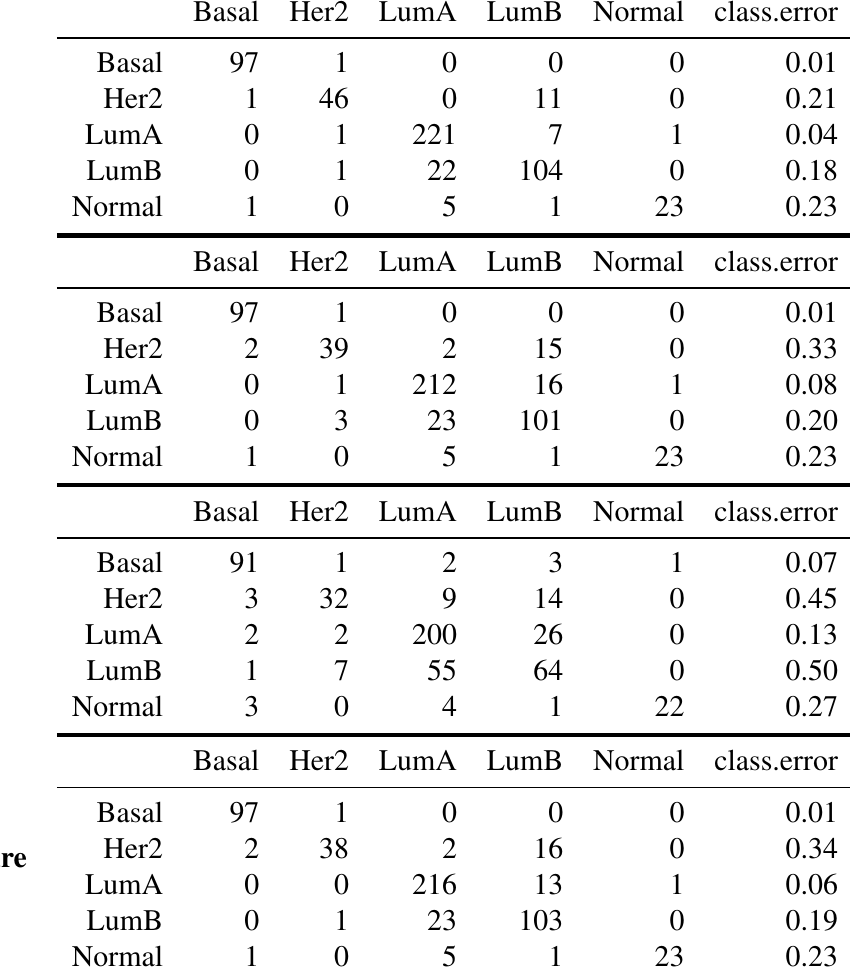
Table 1: Confusion matrices of control model , gene expression model , methylation model , and combined model respectively. Rows correspond to class predictions originating from the PAM50 method, while columns correspond to class predictions of the random forest